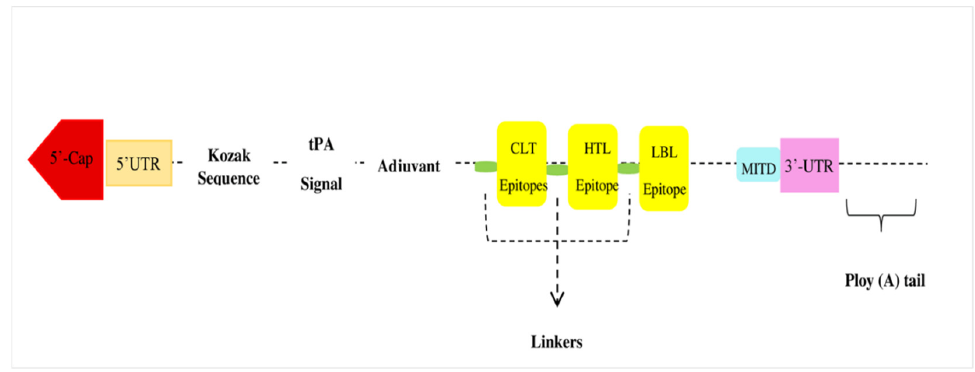
Figure 3. Flow diagram of vaccine construct from N-terminal to C-terminal.